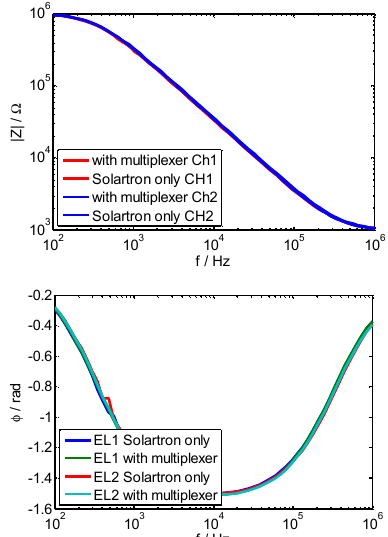
Fig.6: Comparison between measurements with Solartron with and without multiplexer at a dummy load (1 M Ω in parallel with a 470 pF / 1 k Ω – serial combination).